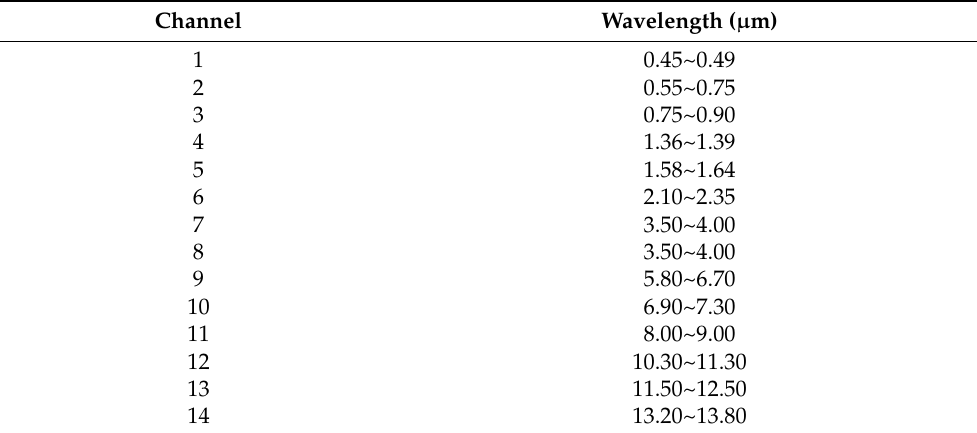
Table 1. The wavelengths of 14 channels of the advanced geostationary radiation imager (AGRI).